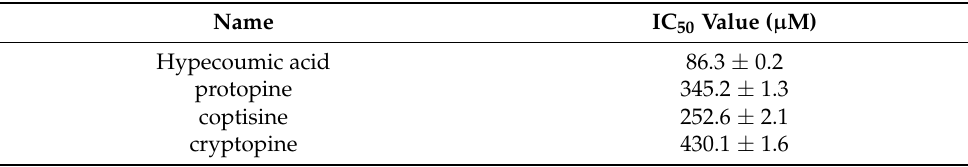
Table 2. Antioxidant activity of compounds 1 – 4